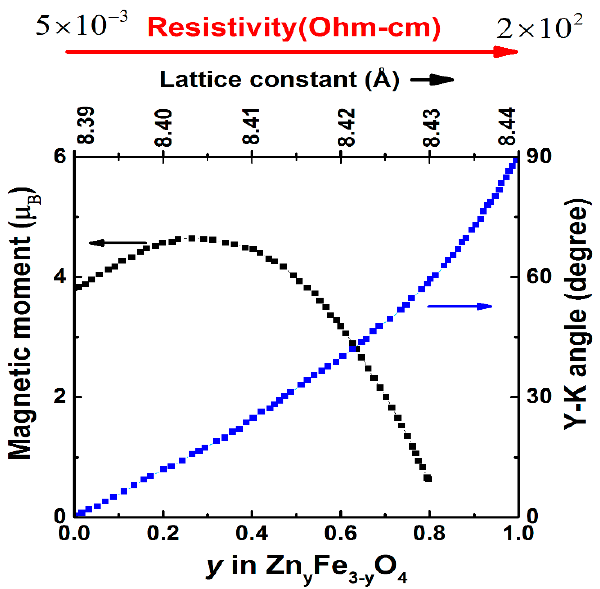
Figure 3. Magnetic moment, Yafet–Kittel angles, and resistivity as a function of y in Zn y Fe 3 − y O 4 at 300 K (Reproduced with permission from [17]. Copyright American Physical Society, 1976).